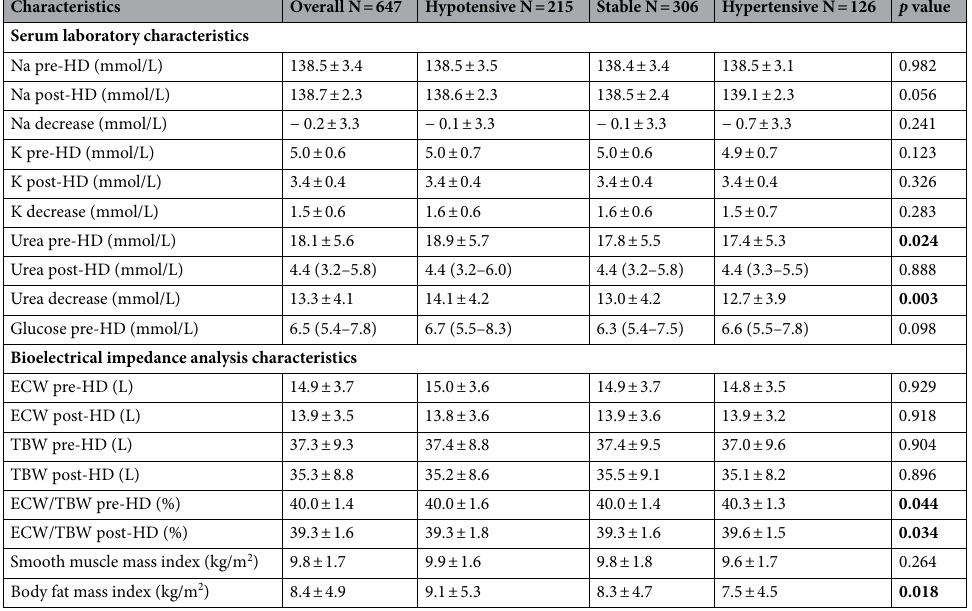
Table 2. Laboratory and bioelectrical impedance analysis characteristics. Bold values correspond to p < 0.05. Na sodium, HD haemodialysis, K potassium, ECW extracellular water, TBW total body water.